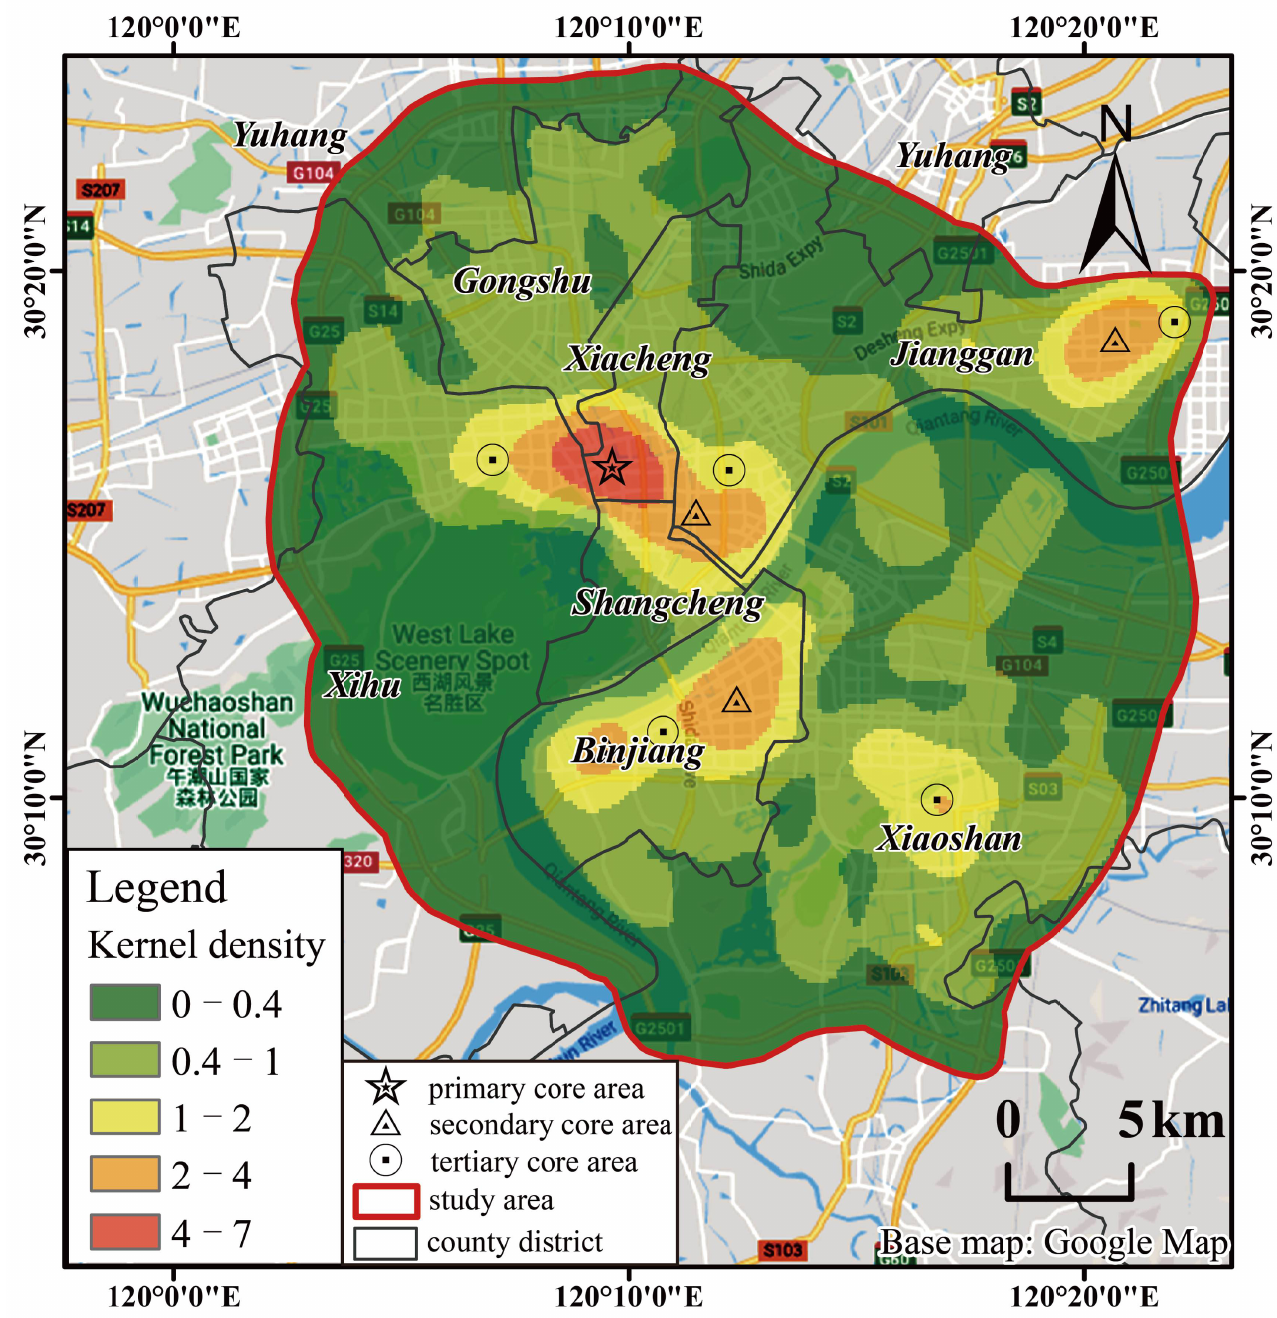
Figure 2. The spatial distribution of weighted kernel density of unmanned aerial vehicle (UAV) logistics network in